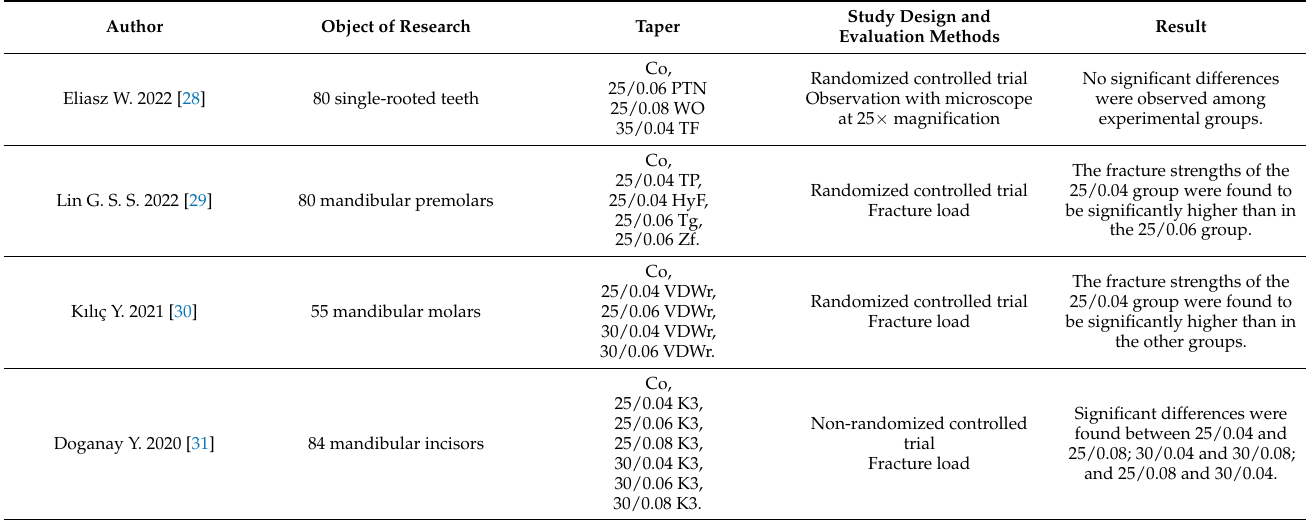
Table 1. PRISMA flow chart. The characteristics of the included